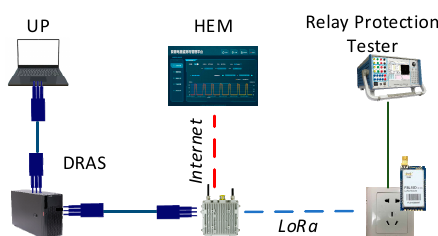
Figure 6. Experimental platform for the functional verification.